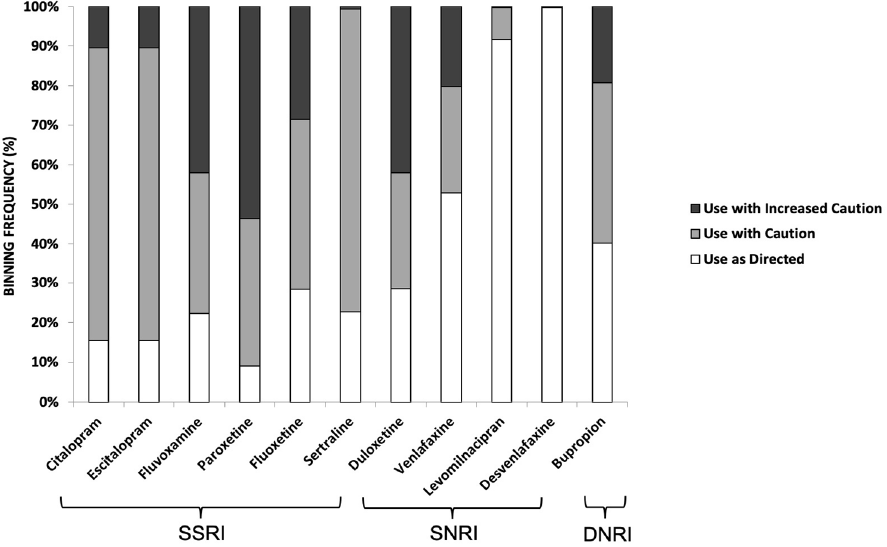
Figure 2. Binning frequency distribution of SSRI, SNRI, and DNRI, which were prescribed to the study cohort based on their GeneSight ® pharmacogenetics reports. Color codes for respective bins were based on the classification outlined by Jablonski et al. [30] . These are: (i) 'use as directed' (no gene-drug interaction detected; annotated by green label in the test report); (ii) 'use with caution' (moderate gene-drug interaction and drug may be effective with dose modification; annotated by a yellow label); and (iii) 'use with increased caution and with more frequent monitoring' (severe gene-drug interaction that may significantly impact drug safety and/or efficacy; as annotated by a red label).